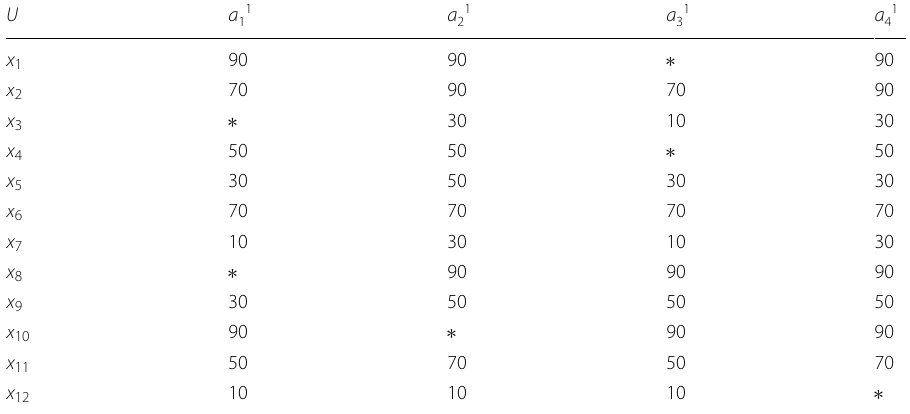
Table 2 The incomplete ordered information table with the first level of granulations